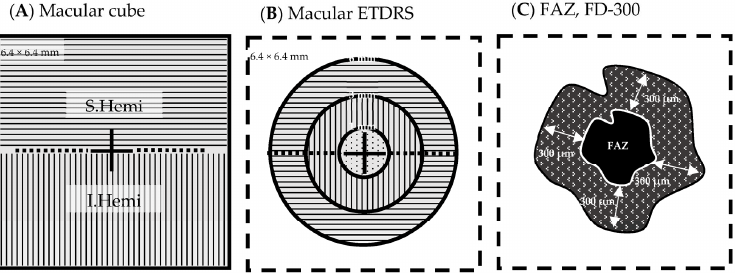
FD.300: vessel density of the 300 µm ring surrounding the FAZ (%) (Figure 4) Deep retinal capillary plexus (DRCP) (Figure 3B,D): same parameters as for SRCP. o Optic disc cube scan (6 mm × 6 mm): radial peripapillary capillaries (RPC) for the whole image all vessels, whole image capillary, inside disc all vessels, inside disc capillary, peripapillary all vessels, peripapillary capillary.